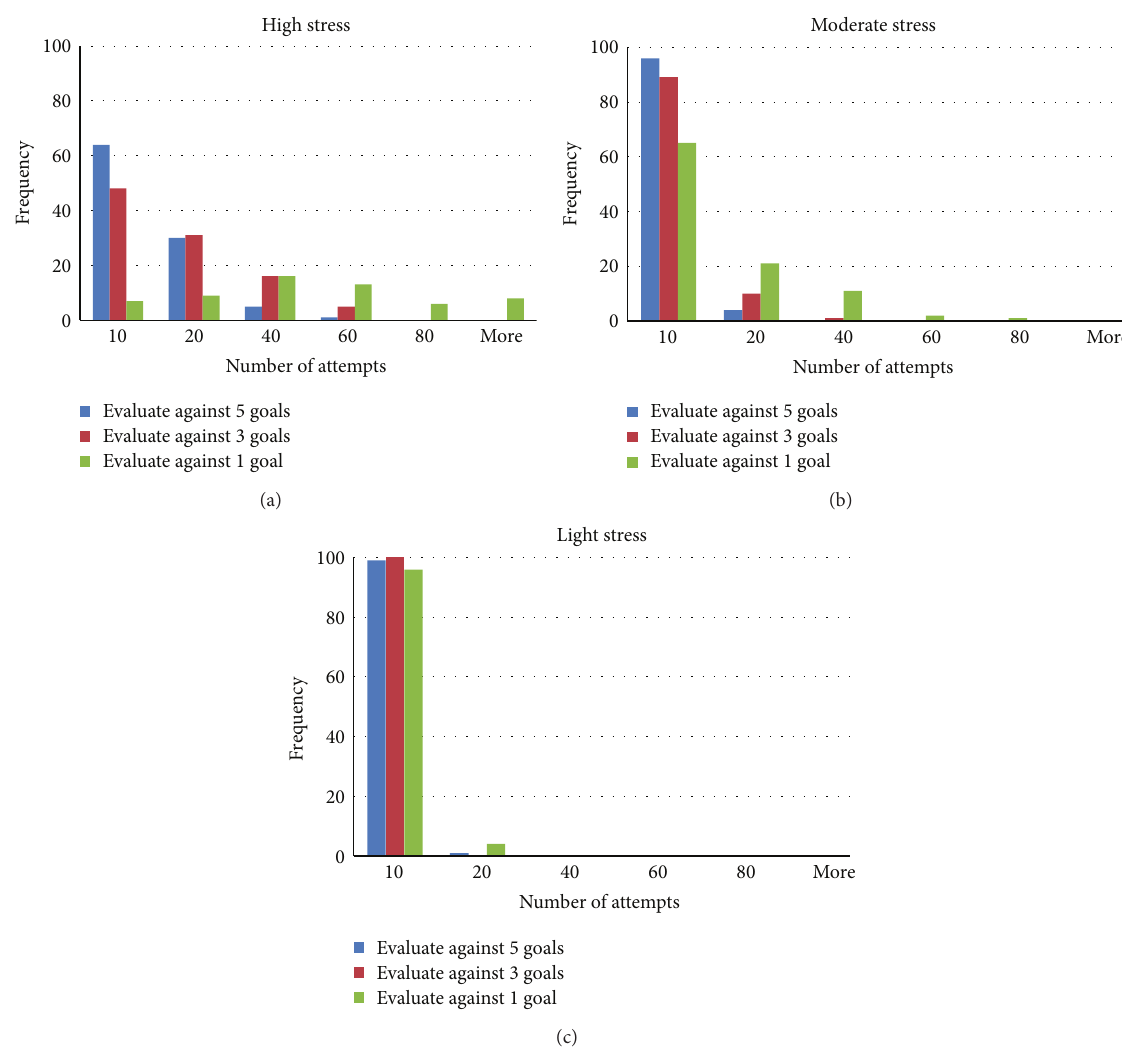
Figure 1: Number of attempts for successful reappraisal for 50-50 agents.